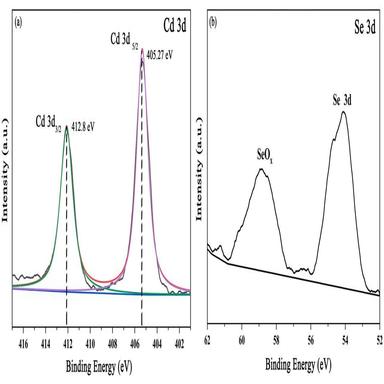
XPS spectra of CdSe materials (a) Cd 3d, (b) Se 3d.